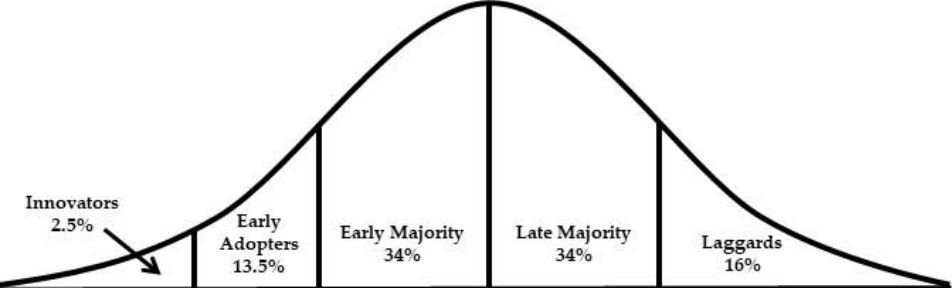
Figure 3. The distribution of the adoption of innovation by adopter group. Rogers assigned estimated percentages to each adopter group that are similar proportions in a bell curve; we present here a re-creation of the original figure presented in [44].